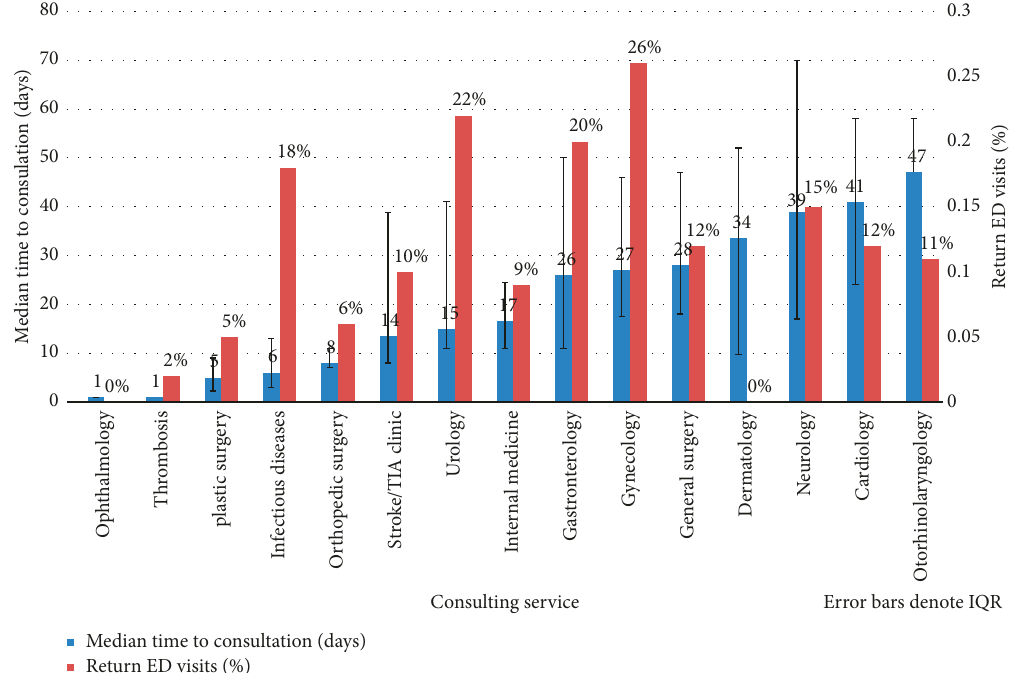
Figure 3: Rate of return ED visits and time to consultation for frequently consulted services for emergency department